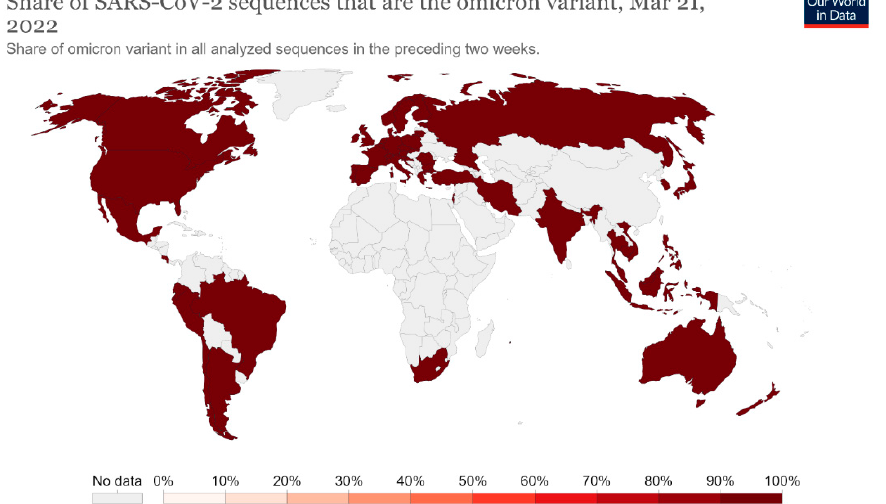
Figure 3. Share of SARS-CoV-2 sequences that are the omicron variant. This dashboard is continually updated and can be accessed at https://ourworldindata.org/grapher/covid-cases-omicron?country=